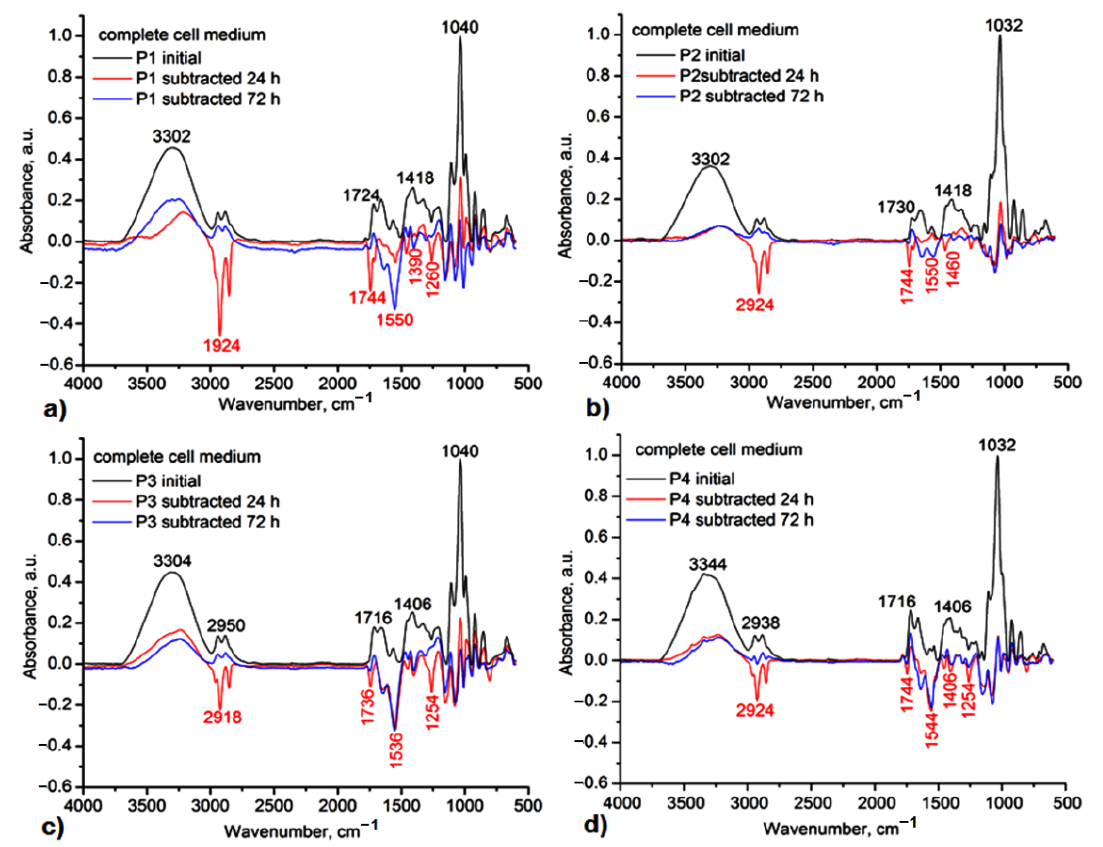
Figure 10. IR subtracted spectra of the P1-( a ), P2-( b ), P3-( c ), and P4-( d ) after 24 h, 48 h, and 72 h immersion in a complete cell medium.